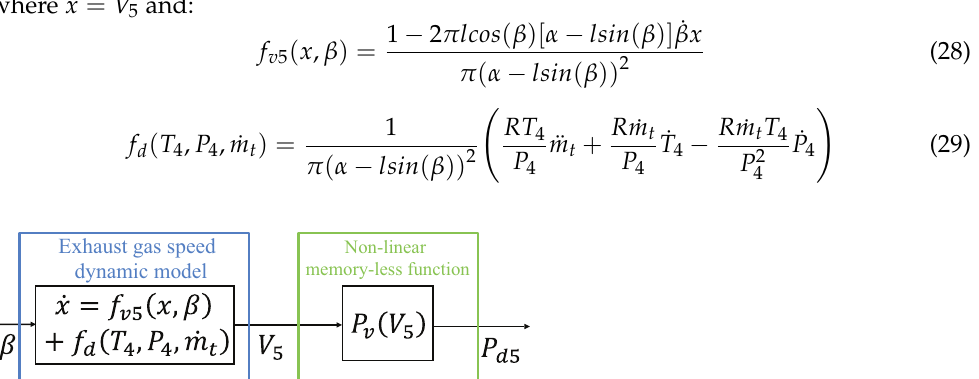
Figure 4. Wiener model structure of the output dynamic pressure. The linear element describes the exhaust gas velocity dynamics and the non-linear static gain transforms the exhaust gas velocity into its dynamic pressure